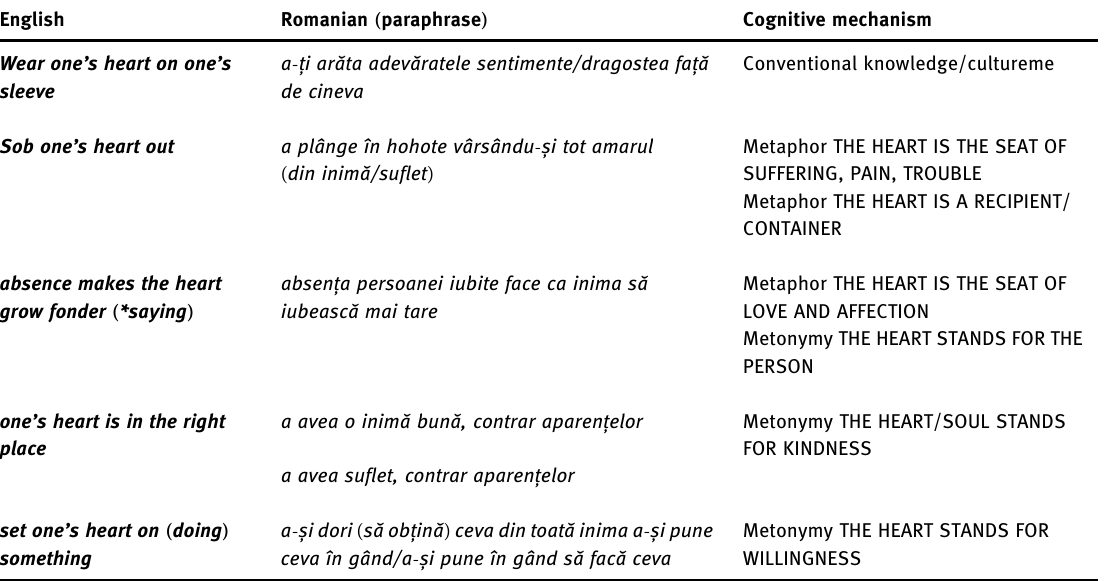
Table 3: English heart idioms and their Romanian translations by